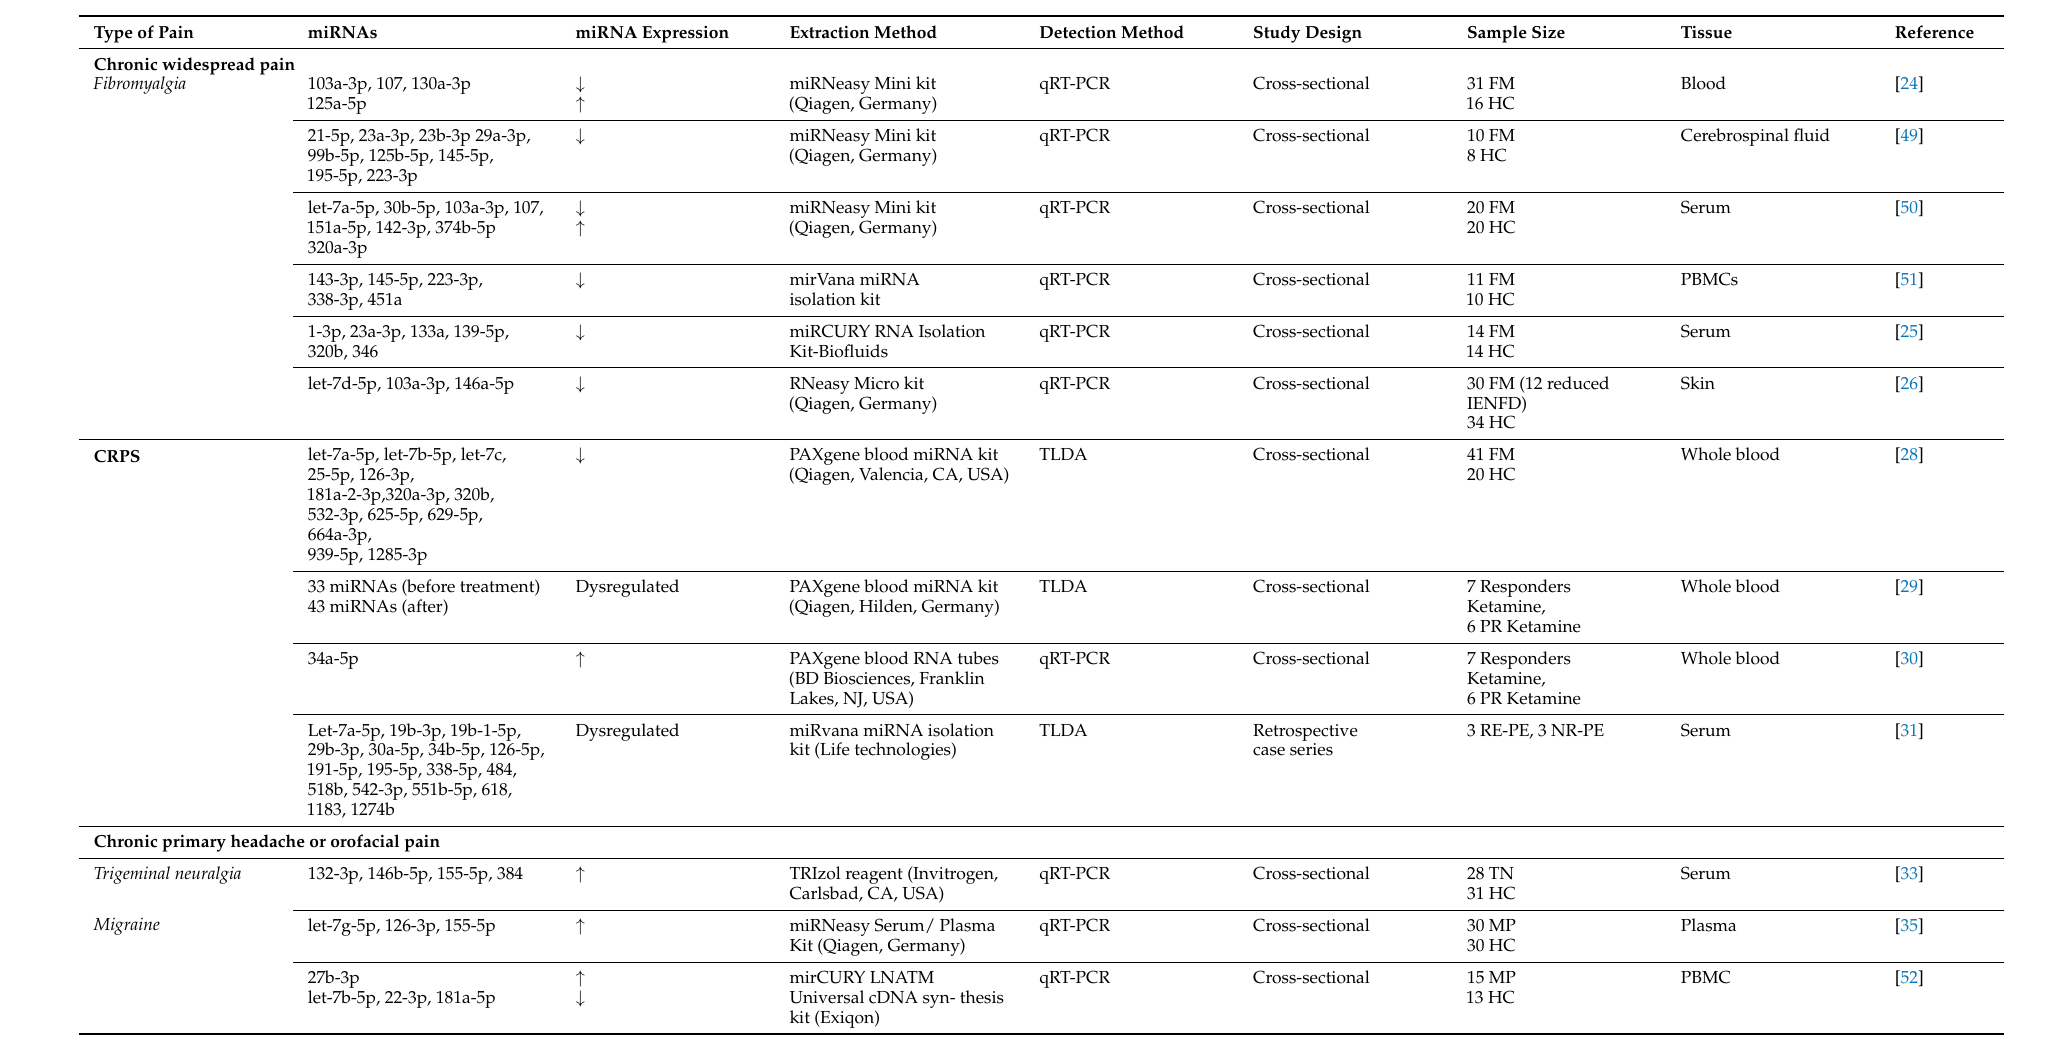
Table 2. MiRNA dysregulation related to chronic primary